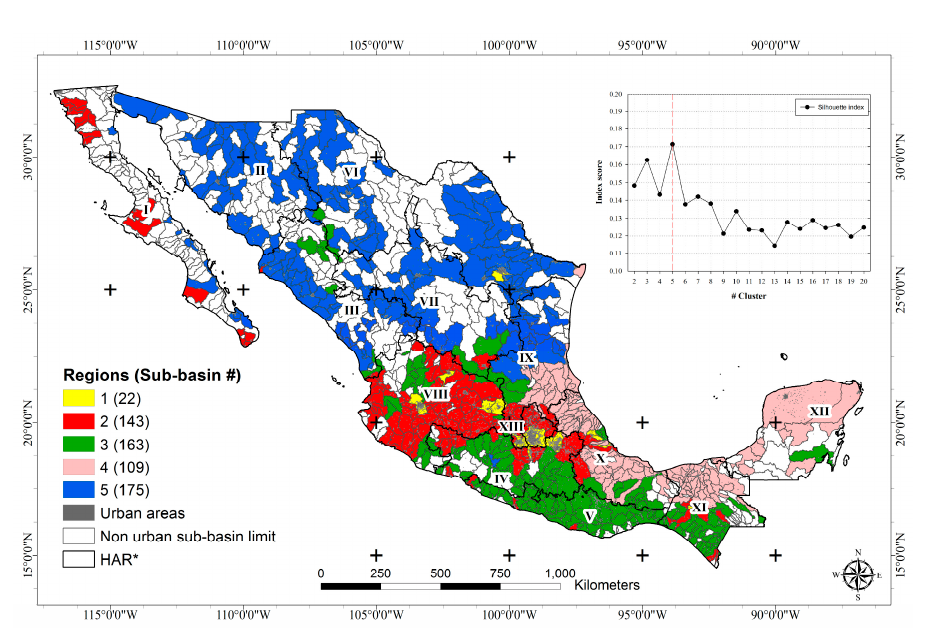
Figure 4. Regionalization of the urban sub ‐ basins. * Hydrological ‐ Administrative Region (Roman numerals). The upper right graph show Silhouette index values from 2 to 20 division groups, dashed red line is the best cluster division for data.